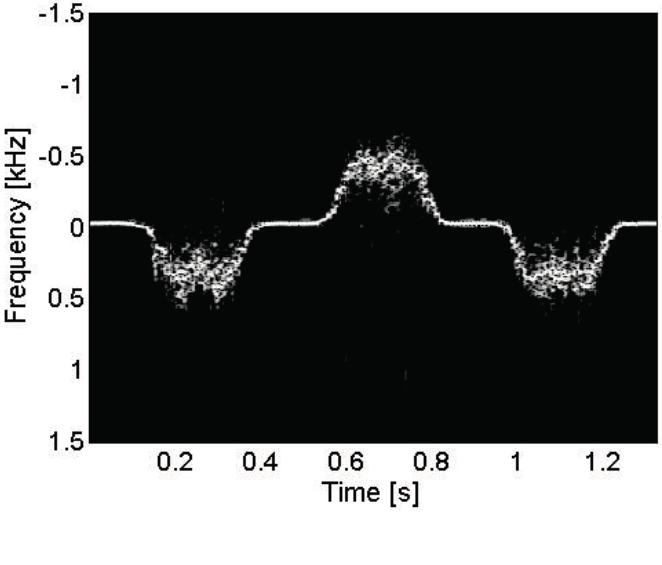
Figure 6. PW Doppler imaging of a moving